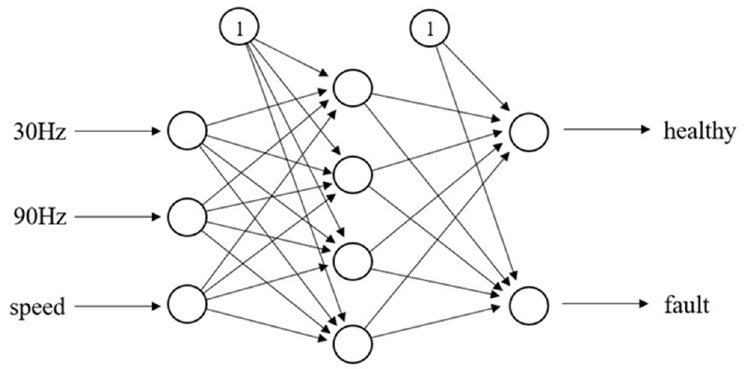
Figure 7. Structure of Neural Network.